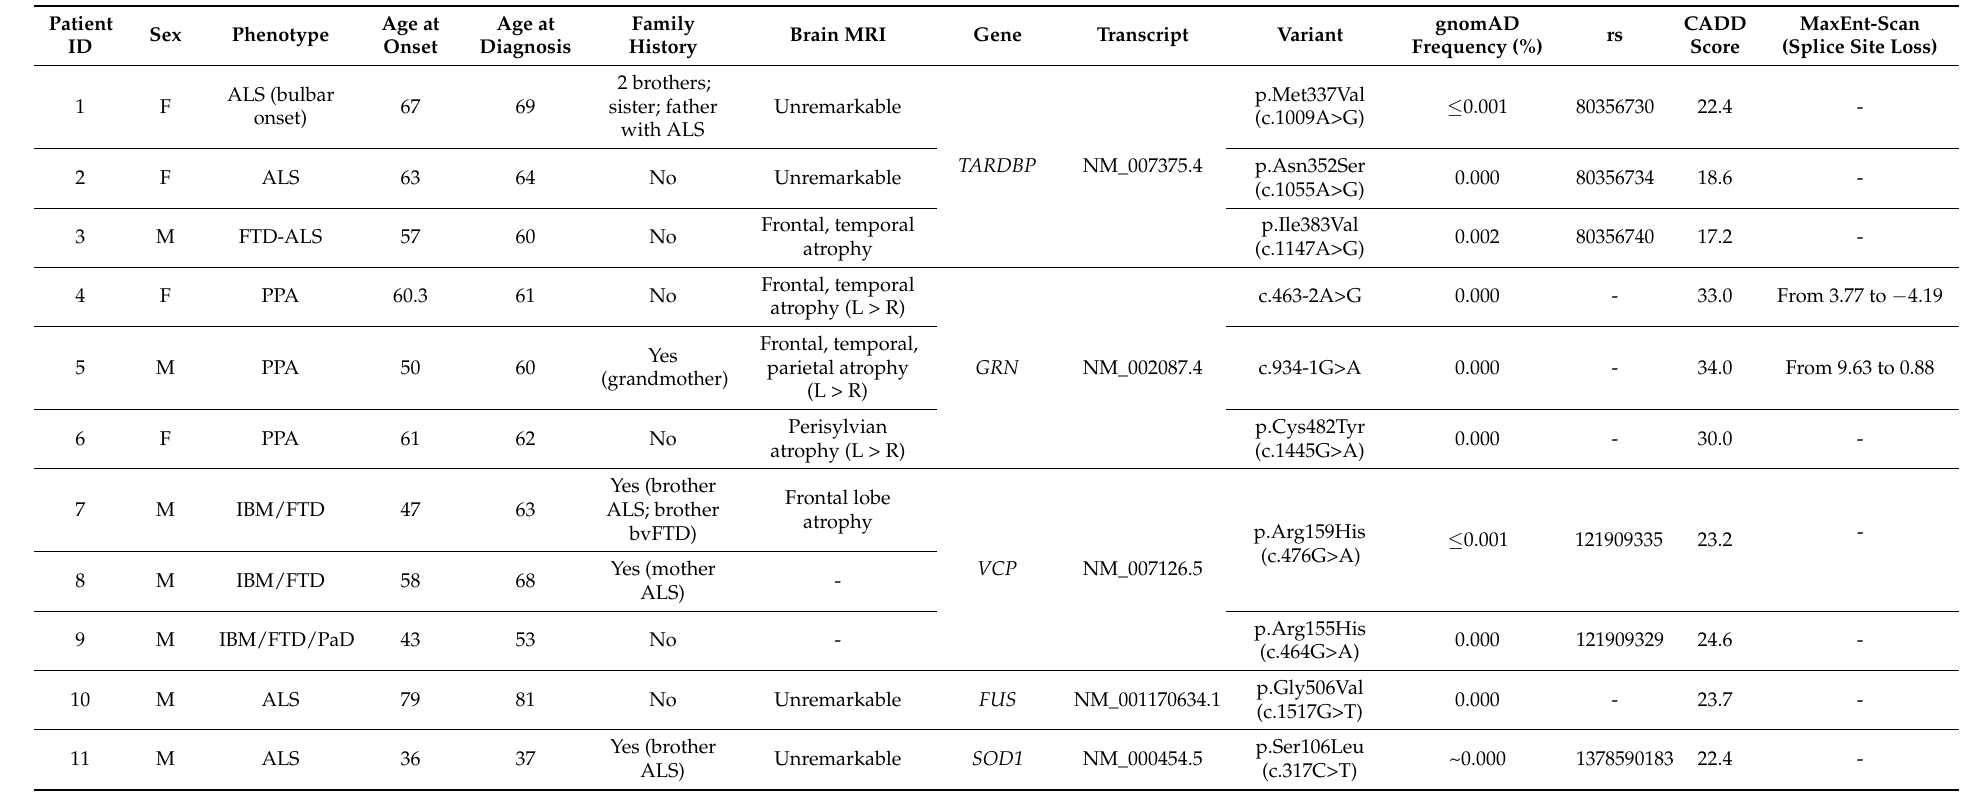
Table 3. Patients with causative variants other than the C9orf72 repeat